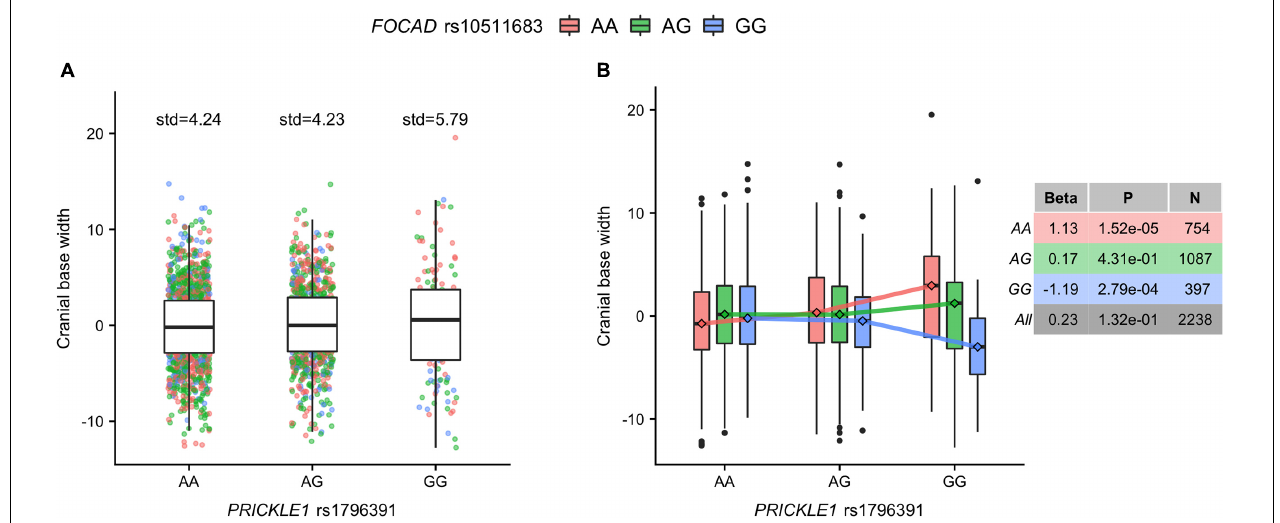
FIGURE 3 | The cranial base width variance heterogeneity at rs1796391 ( PRICKLE1 ) was induced by its gene-by-gene (G × G) interaction effect with rs10511683 ( FOCAD ) on phenotypic mean. (A) Box plots show the residual of cranial base width [after regressing out age, age 2 , sex, height, weight, facial size, and four genetic principal components (PCs)] in the three genotype groups of the variance quantitative trait locus (vQTL) rs1796391 ( PRICKLE1 ), colored by the genotype at the interacting SNP rs10511683 ( FOCAD ). Standard deviations are shown above boxes . (B) Box plots show the distribution of the phenotypic residual in all nine combinations of the genotypes at rs1796391 ( PRICKLE1 ) and rs10511683 ( FOCAD ). The x -axis, y -axis, and the color scheme are the same as those in (A) . Medians are represented by diamonds and connected to form segments, the slopes of which indicate the group-specific effects of rs10511683 ( FOCAD ). The non-parallel pattern is the hallmark of statistical interaction. Table to the right shows the association (with the mean of cranial base width) beta coefficients, p -values, and sample sizes for rs10511683 ( FOCAD ) in subgroups defined by the genotype at rs1796391 ( PRICKLE1 ) and the combined sample.